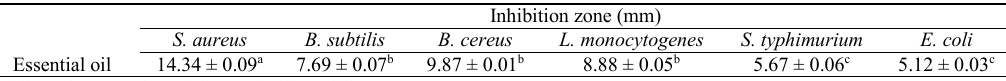
Table 3. Antibacterial effect of nano emulsion of clove essential oil against food-borne pathogenic bacteria